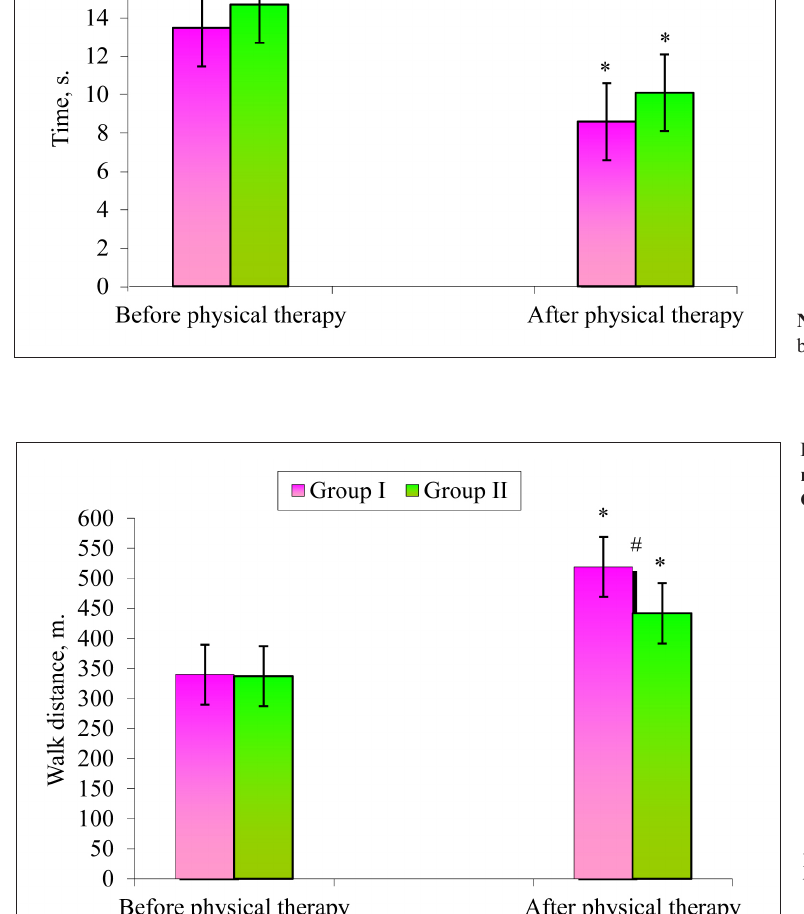
Figure 2. Test performance average time values in the “Up and go” test before and after physical therapy